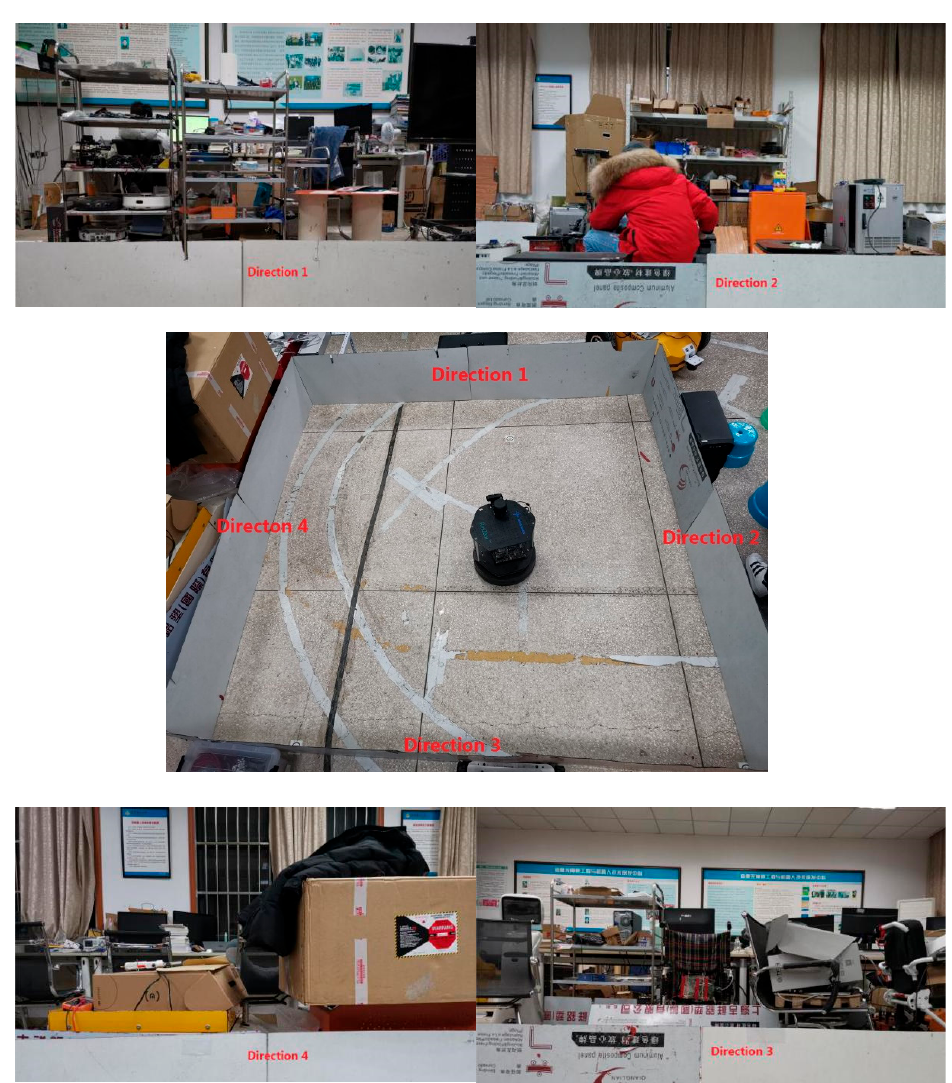
Figure 11. Robot in a real-world environment. The top two and bottom two images are captured from direction 1 to direction 4 and the center image shows the robot in the center of the built square